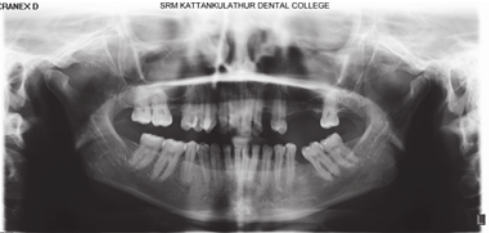
Figure 4: Orthopantomograph shows coronal radiolucency in #14 and #15 with multiple edentulous spaces. No periapical radiolucen- cies were